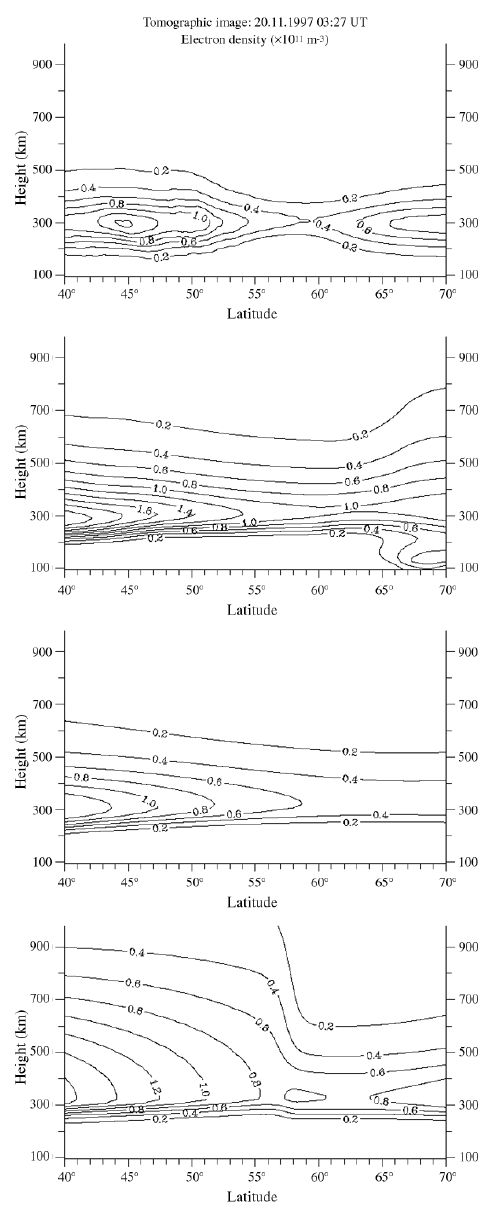
Fig. 3. An actual tomographic image of electron densities (upper panel), with corresponding outputs from three ionospheric models: (in descending order of panels) IRI-95, PIM and COST 238. From Dabas and Kersley (2003), reproduced by permission of the American Geophysical